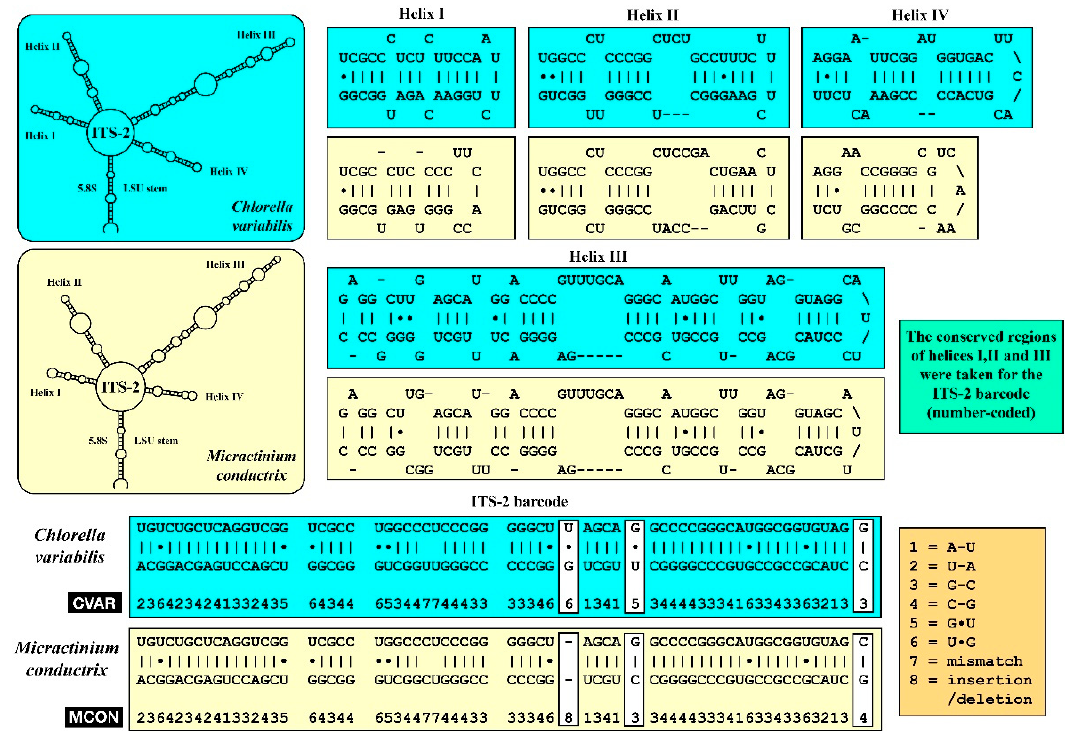
Figure 6. ITS-2 secondary structure of Chlorella variabilis (blue) and Micractinium conductrix (yellow). The ITS-2 barcodes of both species (CVAR and MCON) is given as number codes. The ITS-2 barcodes of both species (CVAR and MCON) is given as number